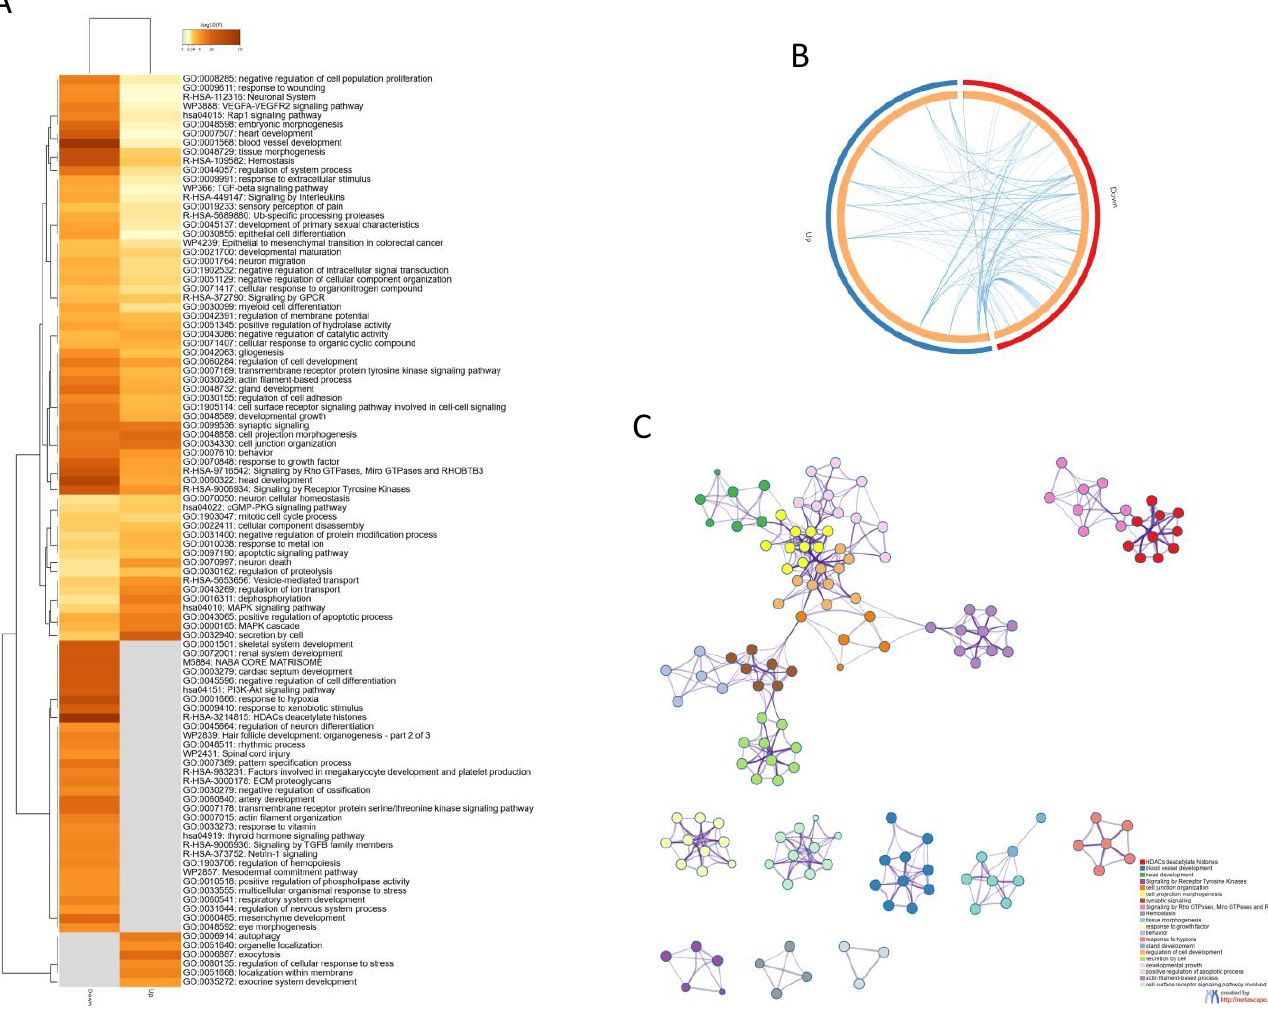
Figure 2. ( A ) Heatmap showing the top 100 enriched terms among the upregulated and downregulated DEGs identified in the meta-analysis; ( B ) Circos plot showing the enriched biological processes overlapping among the up- and downregulated DEGs identified in the meta-analysis; ( C ) network showing the connection among the most enriched pathways by the genes identified in the meta-analysis.